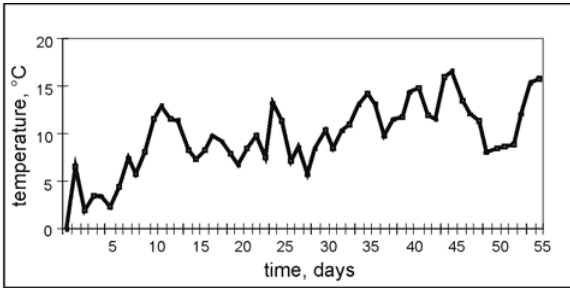
Fig. 3. Average temperature of the ambient air (produced gas)